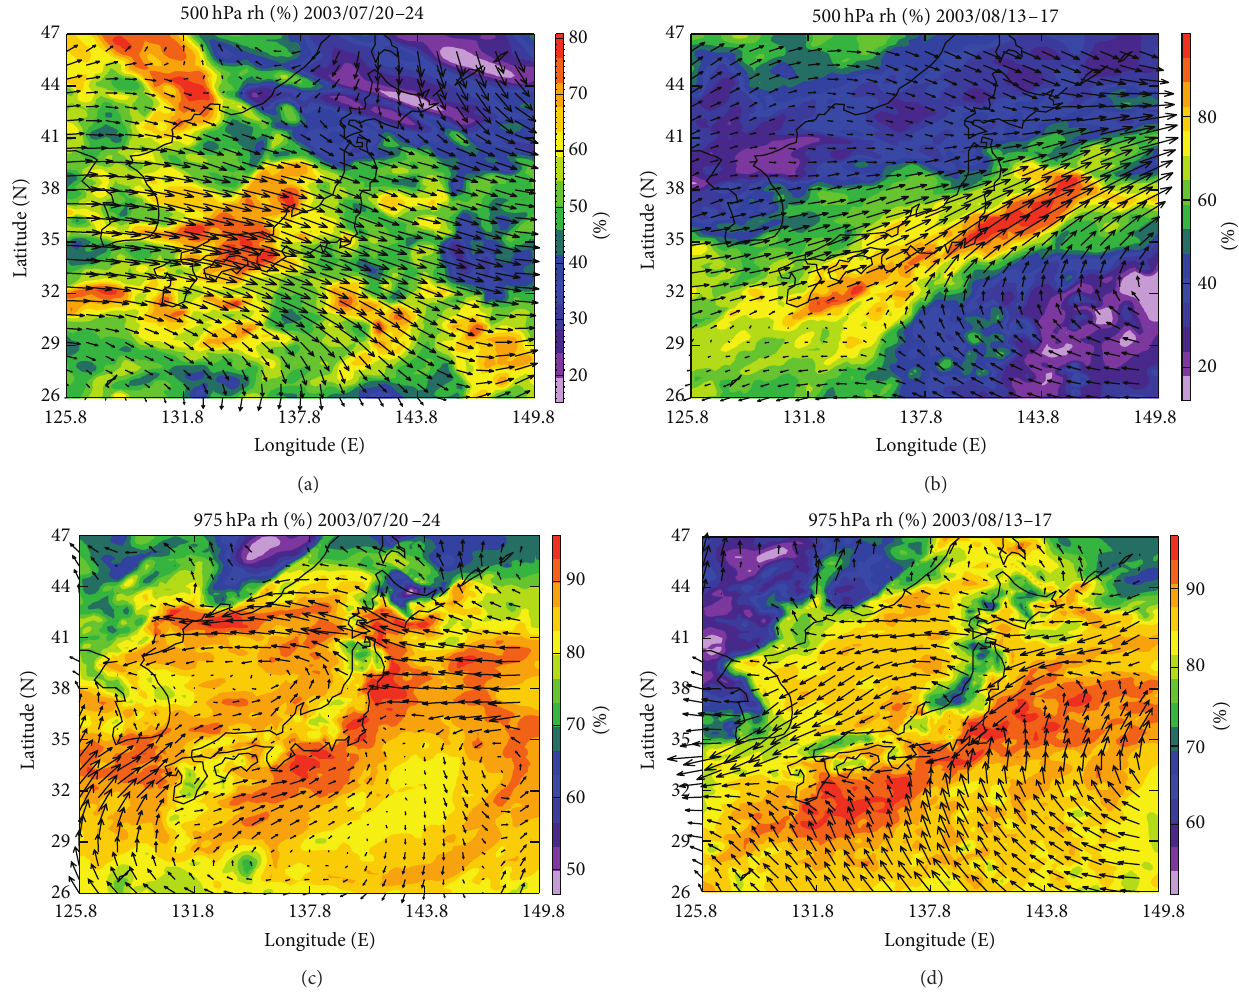
Figure 1: Distribution of average relative humidity [%] (color shading) and the horizontal wind field (vectors) for July 20–24 (a and c) and August 13–17 (b and d) at 500 hPa (a and b) and 975 hPa (c and